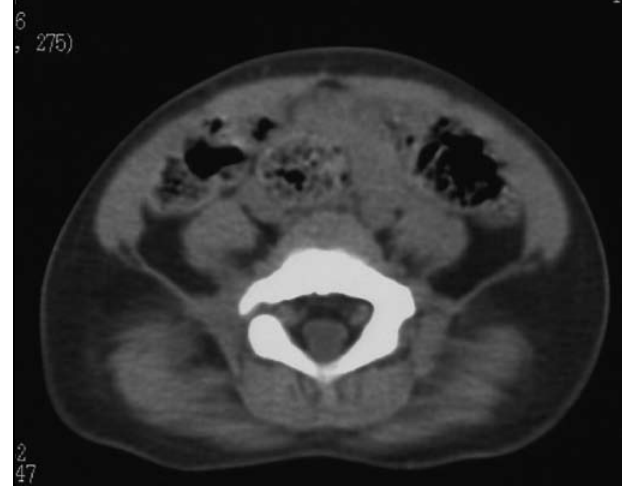
Fig. 2. Axial CT section of pelvis in soft-tissue window setting shows bilateral absence of bony ilia replaced by band-shaped soft-tissue density